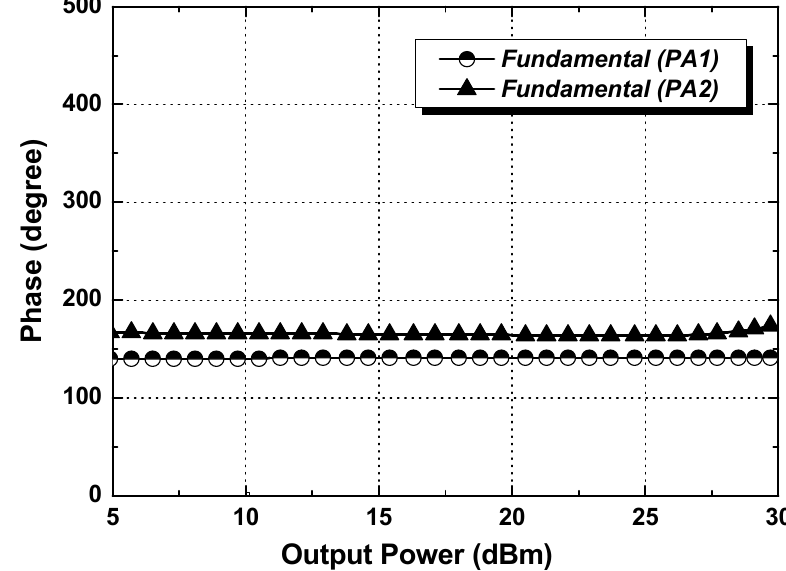
Figure 8. Two-tone simulated results for the phase of fundamental currents.